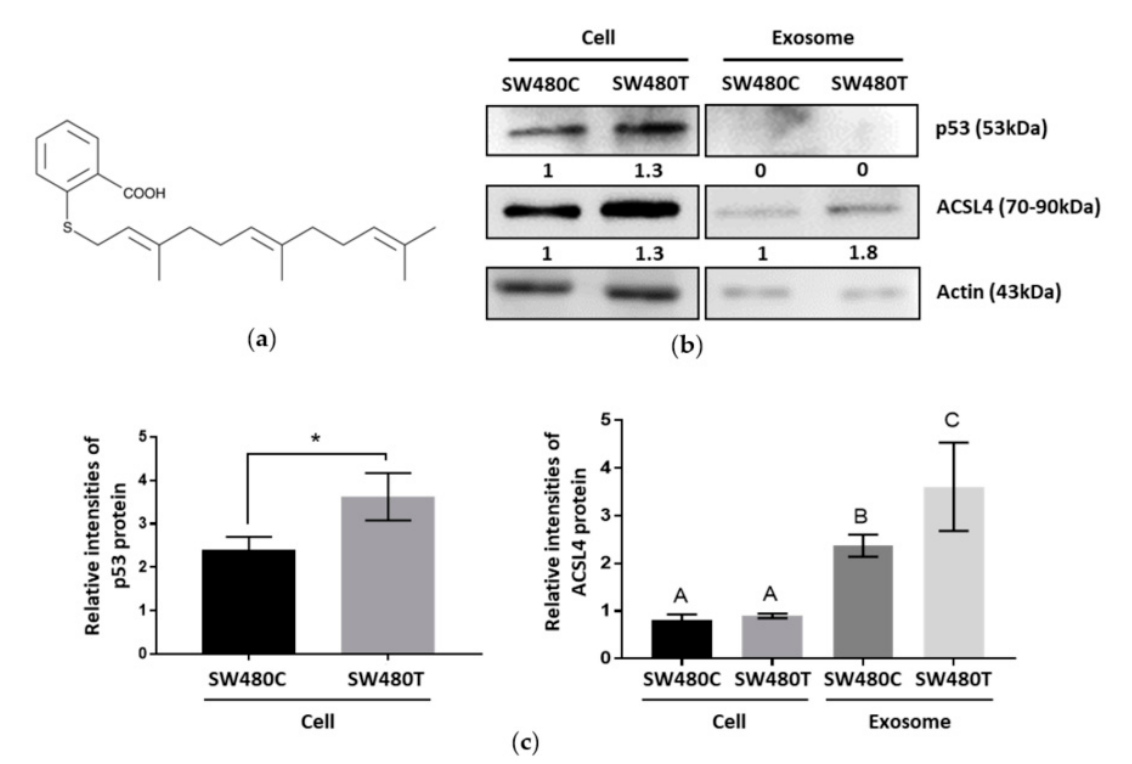
Figure 5. Western blot analysis of the effect of FTS on SW480 cells and the secreted exosomes. ( a ) Structure of FTS compound; ( b ) Western blotting of p53 and ACSL4 with actin as the loading control; ( c ) Relative intensities of p53 and ACSL4 proteins expression which normalized to actin. Means with different letters indicate significant difference between groups ( n = 3, p < 0.05; one-way ANOVA–Tukey’s multiple comparison tests).